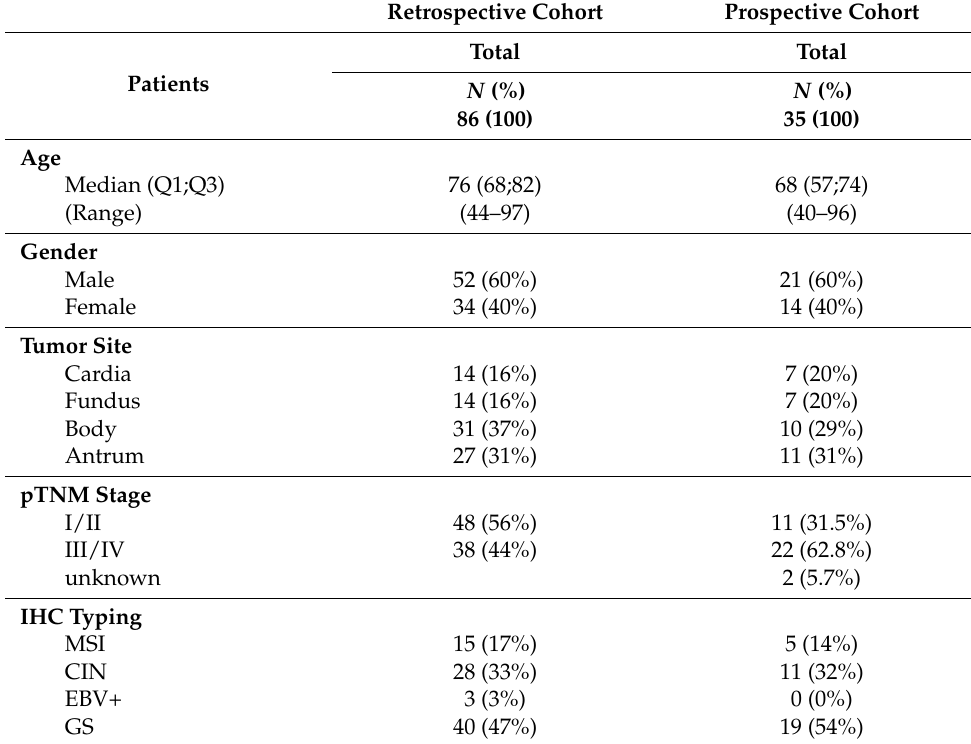
Table 1. Clinicopathologic characteristics of gastroesophageal adenocarcinoma (GEA) patients, retrospective and prospective